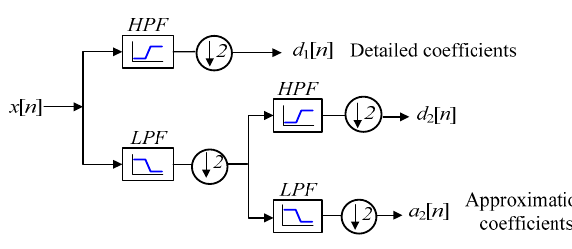
Figure 9. Wavelet decomposition tree using two levels of decomposition.